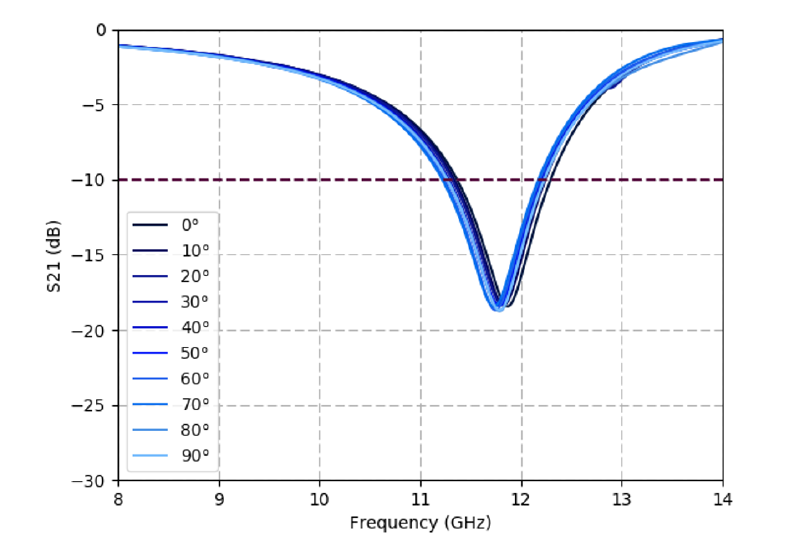
Figure 5. Spiral-based FSS demonstrates polarization independence. Simulated S 21 response of a triangular lattice under varying polarization angle values ( φ ) with constant incidence angle ( θ = 0°) in the flat configuration ( β =